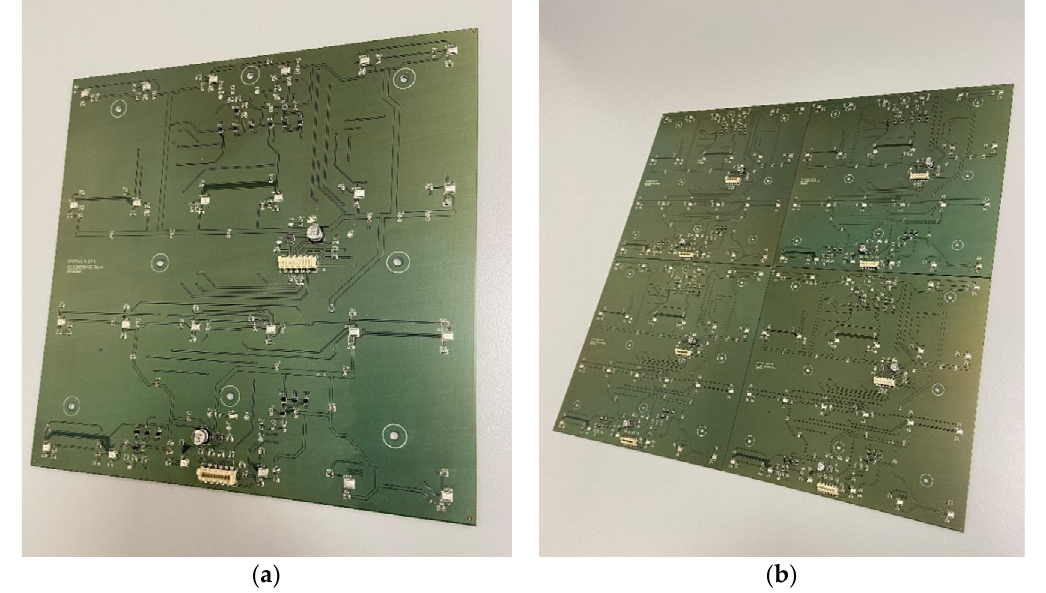
Figure 10. ( a ) A single printed circuit board with mounted electronic components for the prototype of plate-shaped acoustic camera; ( b ) Four boards arranged together to form Acoustic Camera 2 .